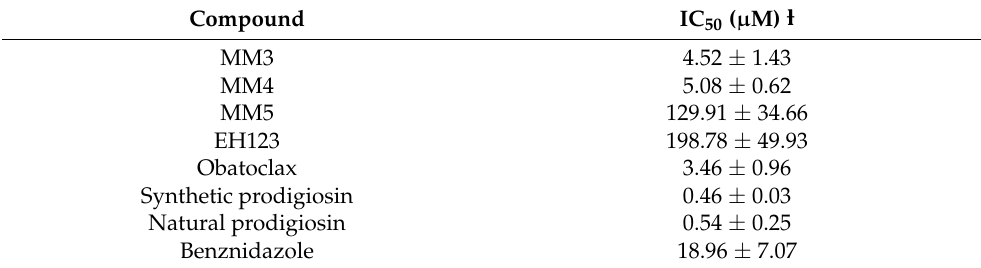
Table 2. Biological activity of tambjamines, Obatoclax, synthetic and natural prodigiosins, and benznidazole against trypomastigotes/amastigotes of T. cruzi (CLB strain) at the highest concentra- tion assayed (16 µM).